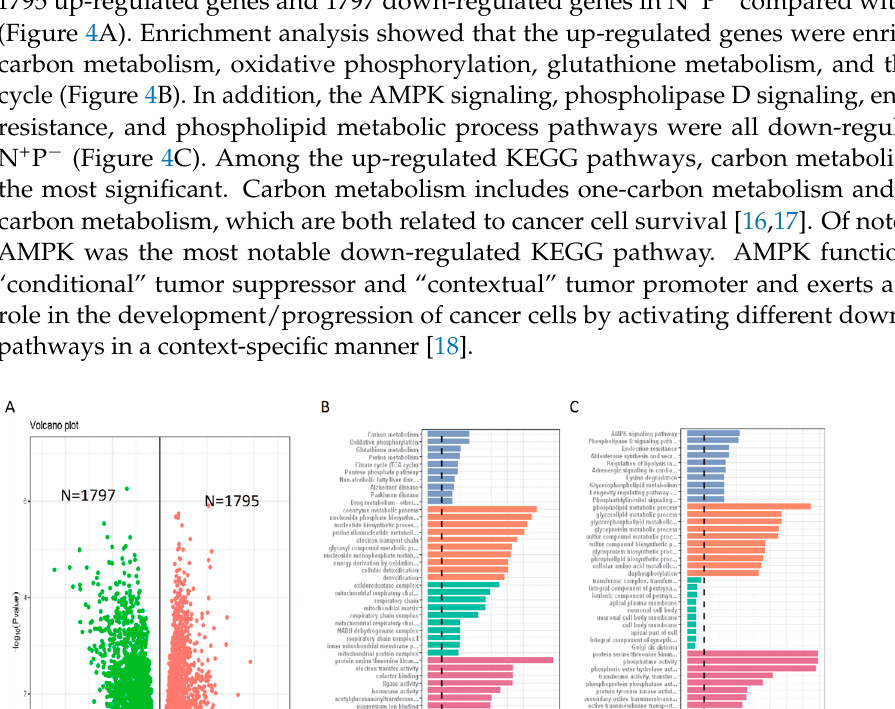
Figure 4. Gene expression profile of N + P − GBM samples. ( A ): Volcano plot of differential gene expression between the N + P − and N − P + . ( B ): GO enrichment analysis of up-regulated genes (1795 genes). ( C ): GO enrichment analysis of down ‐ regulated genes (1797 genes).